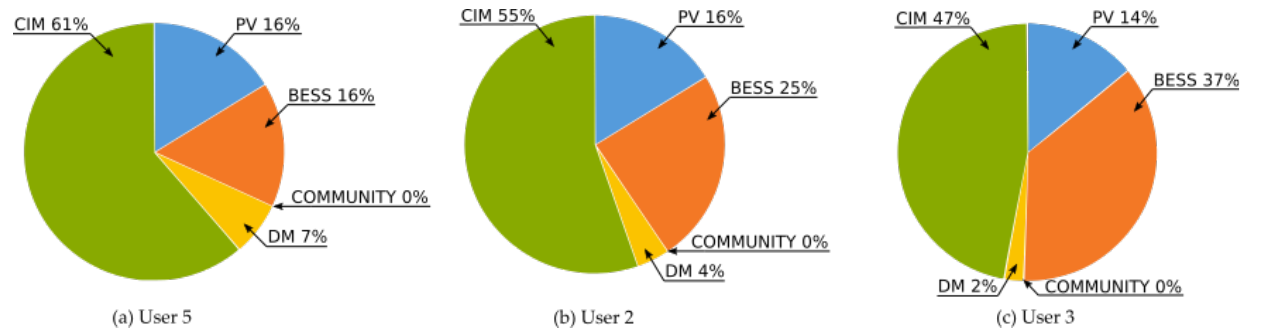
Figure 10. Case study D total energy cost percentage breakdown of the main three consumption profiles analysed (high, medium and low).